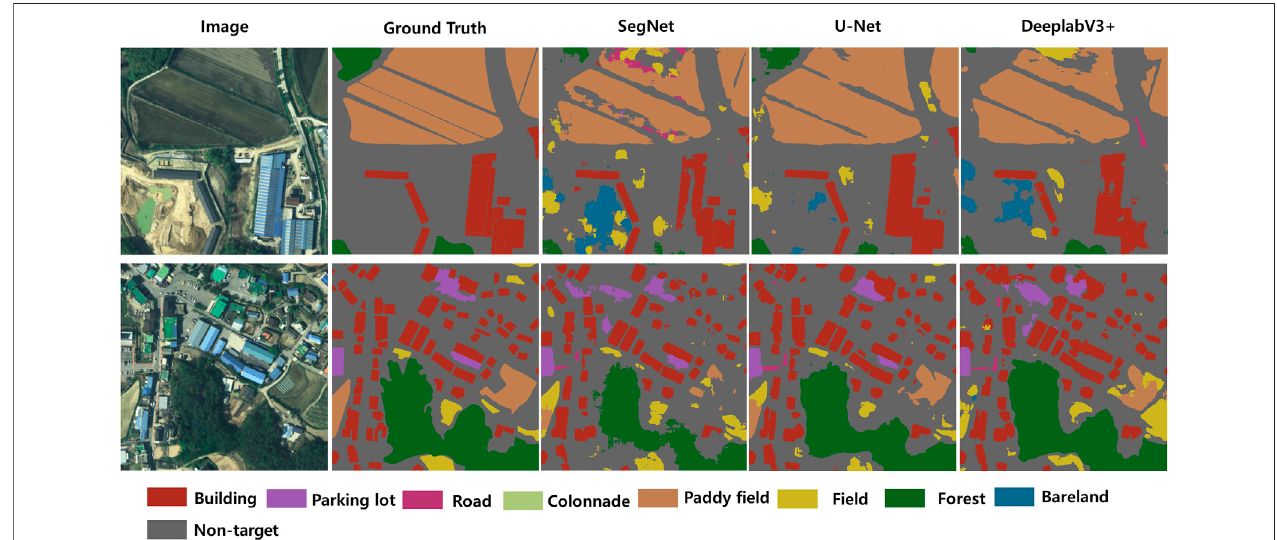
FIGURE 6 | Result aerial image of SegNet, U-Net and DeeplabV3+ algorithms.